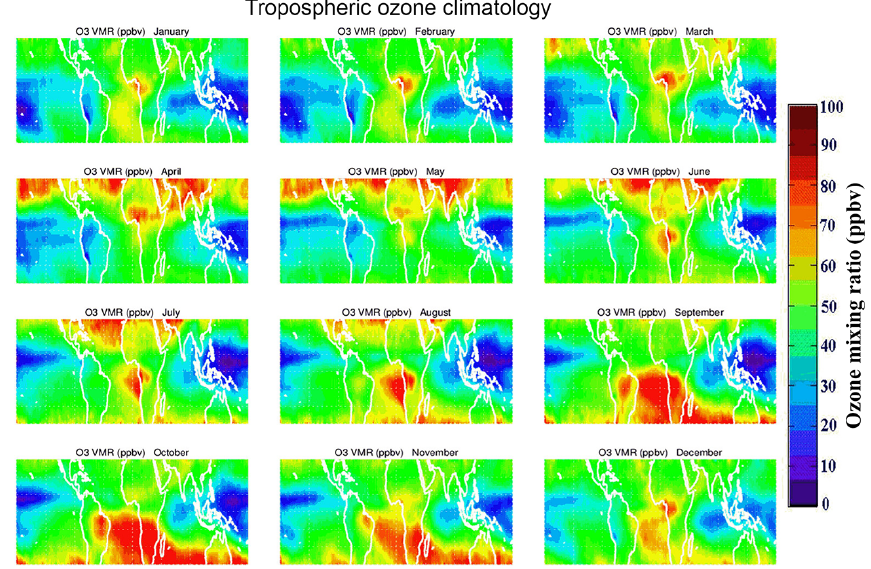
Figure 6. Similar to Fig. 5, but instead plotting monthly-mean climatology maps of OMI/MLS VMR (units ppbv) for OMI near clear-sky scenes (i.e., radiative cloud fractions less than